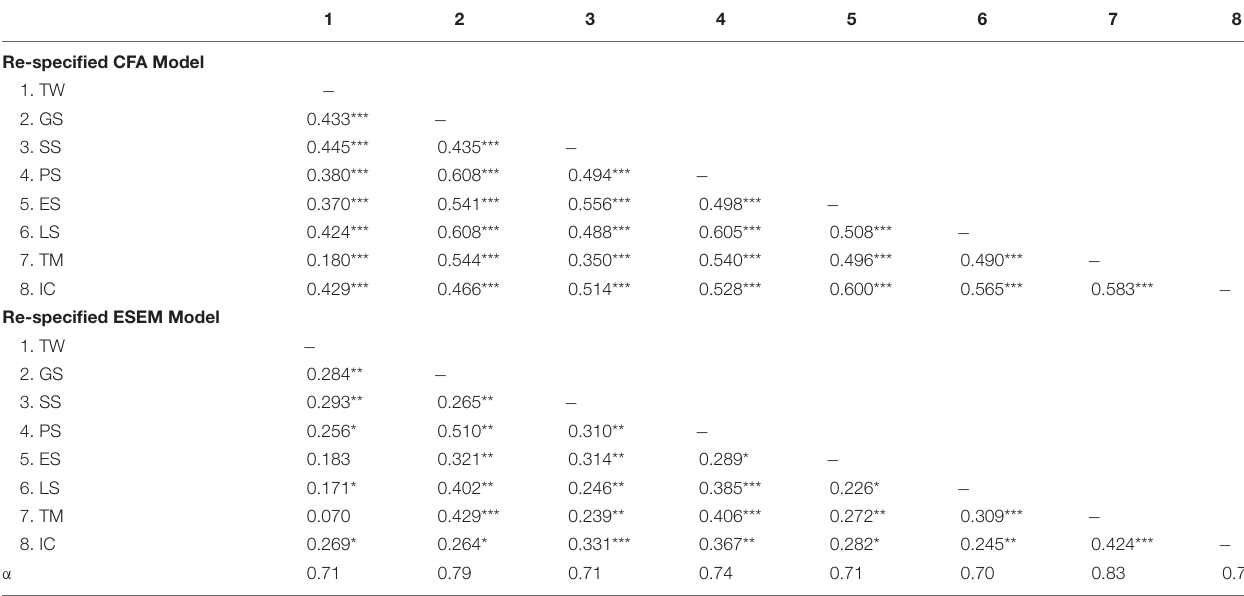
TABLE 6 | Inter-factor correlations for the re-specified CFA and ESEM